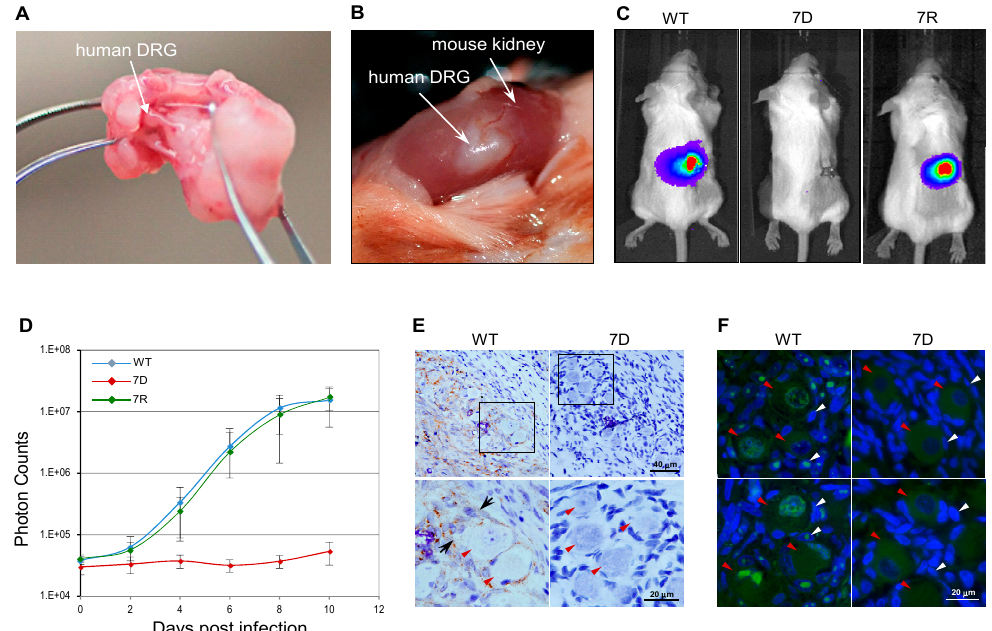
Figure 3. ORF7 is essential for viral replication in human neurons in vivo. ( A ) Human dorsal root ganglia (DRG) isolated from the fetal spinal cord. ( B ) Human DRG were implanted under the kidney capsule of SCID mice and four weeks later, infected with 100 PFU of cell-free wild-type (WT), the ORF7-deleted mutant (7D) or the 7D rescue (7R) VZV, respectively. ( C ) The bioluminescence signal recorded in SCID mice every other day after intraperitoneal administration of D-luciferin for 10 days. Images at 10 days post-infection (dpi) are shown. ( D ) The total photon counts from each sample (five animals / viral sample) were quantified, analyzed and used for generating growth curves. ( E ) At 10 dpi, WT- and 7D-infected DRG harvested from SCID mice were stained for gE (brown) and counterstained with hematoxylin (blue). Lower panels represent a higher magnification of selected areas of the upper panels. Red arrowheads indicate neurons. Vacuolization and possible neuron-satellite cell aggregates (black arrows) were observed in the WT-infected sample, correlating with productive replication and widespread presence of viral gE antigen (brown), while 7D samples retained normal DRG morphology and no gE was detected. ( F ) Fluorescence in situ histochemical staining of the infected DRG samples using a VZV genomic DNA probe (green) revealed intranuclear signals from nuclei of both neurons (red arrowheads) and adjacent satellite cells (white arrowheads) in WT-infected tissue, indicative of active viral DNA replication within intranuclear replication centers; no 7D DNA was detected in any of the samples tested at the experimental endpoint.